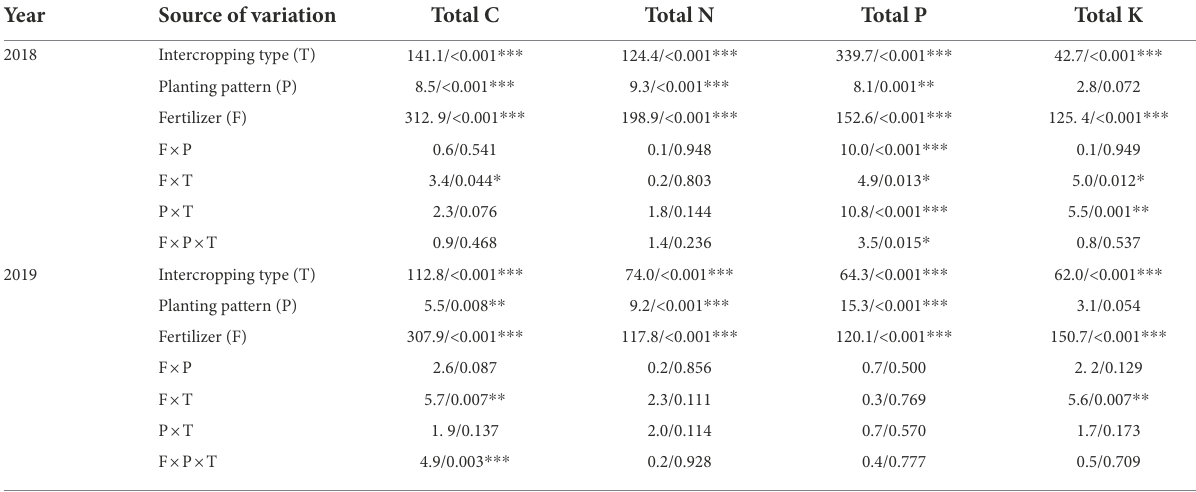
TABLE 5 Three-way ANOVAs of the effects of intercropping type (T; corn–soybean/peanut/millet), planting patterns (P; one corn monoculture and three planting patterns of corn intercropping with soybean/peanut/millet), fertilizer level (F; normal vs. reduced), and their bi − /tri-interactions on nutrients element of corn in 2018 and 2019 ( F / P